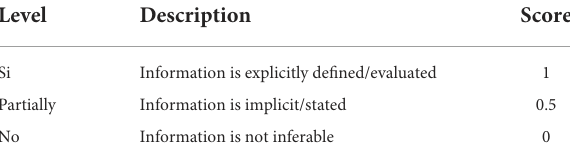
TABLE 1 Quality assessment checklist. TABLE 2 Acronyms to classify